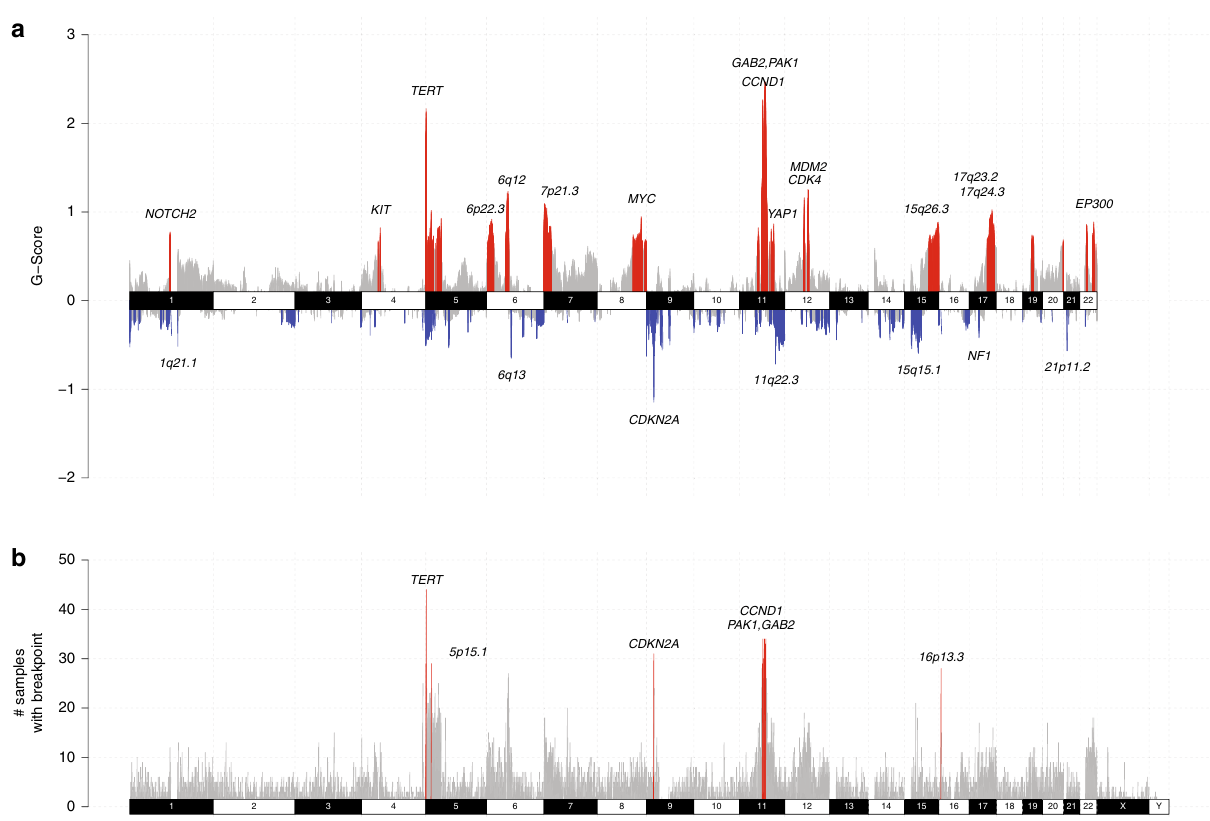
Fig. 5 Recurrent focal regions of copy number and rearrangement breakpoints. a Focal regions of recurrent ampli fi cation (red) and deletion (blue) as identi fi ed by GISTIC2. Genes and chromosomal cytobands of interest are annotated in the plot. b Regions of recurrent rearrangement breakpoints as identi fi ed by RETREAD. The plot shows 1 Mb windows that have 1 or more rearrangements. Bars in gray represent windows that are not signi fi cant ( q > 0.2), and red bars indicate regions that are signi fi cantly enriched ( q <